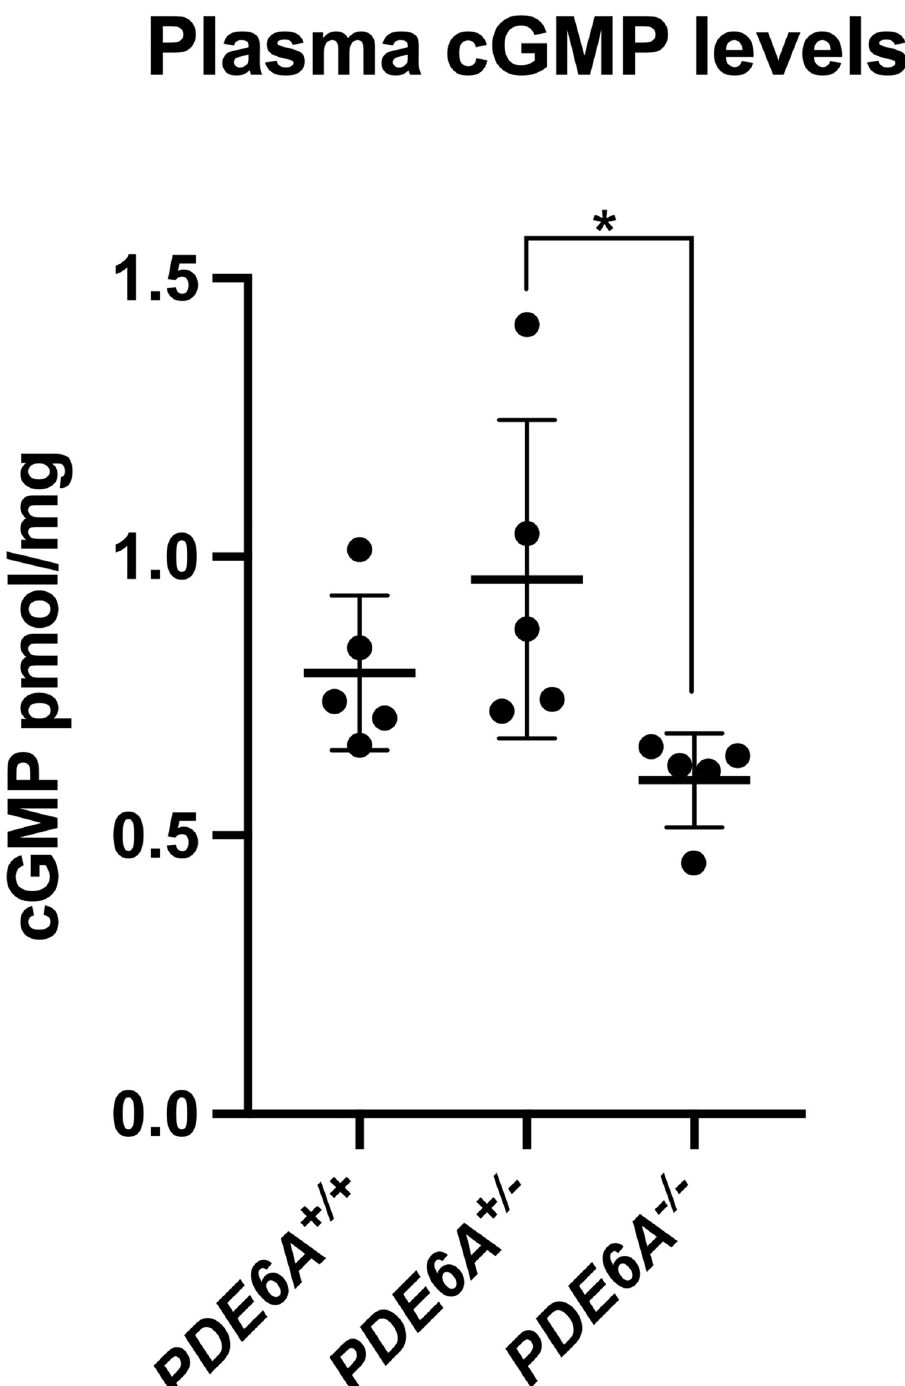
Fig 2. Mean plasma cGMP levels in 2-month-old animals. The mean serum cGMP levels of the PDE6A -/- animals was lower than that the other two groups. The difference was only significant between PDE6A -/- and PDE6A +/- animals. � p =